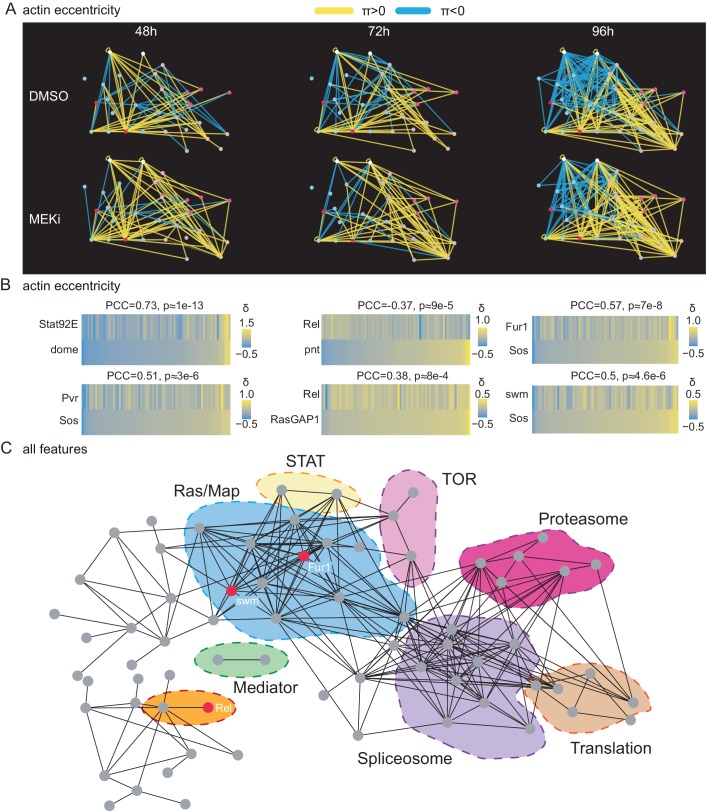
A correlation network of treatment-sensitive interactions maps pathways modules.(A) Network of genetic interactions between selected genes. The networks include all candidate Ras-signaling (blue), Jak/STAT-signaling (white), Tor-signaling (pink), proteasome (red), translation (orange) and splicing (purple) related genes. Significant (FDR < 0.1) alleviating interactions are shown in yellow. Significant (FDR < 0.1) aggravating interactions are shown in blue. All interactions are based on the cell eccentricity feature. Interactions become more abundant and stronger over time, more alleviating interactions can be observed under MEK inhibition. Ras and Jak/STAT related genes are mostly connected by aggravating interactions. (B) Correlations of treatment-sensitive interaction profiles between known regulators and candidate genes. Profiles of all δ-scores along cell eccentricity and 76 query genes were constructed for 168 target genes and pairwise correlations were calculated. Shown is the Pearson correlation coefficient (PCC) and asymptotic p-value as implemented in the R package Hmisc. All correlations shown are significant with an p-value < 0.01. Jak/STAT and Ras components show high correlations as expected. Rel appears as negative, Fur1 and swm as positive regulators of Ras signaling. (C) Pairwise correlation network of treatment-sensitive interaction profiles across all 16 features. Shown are all genes with at least one edge. Edges are drawn if two gene’s δ-profiles correlate with PCC > 0.5. Nodes are ordered by force directed spring embedded layout. A high degree of clustering of known pathways indicates meaningful correlations.10.7554/eLife.40174.021Figure 7—source data 1.Cytoscape session file to reproduce Figure 7A.10.7554/eLife.40174.022Figure 7—source data 2.Cytoscape session file to reproduce Figure 7C.